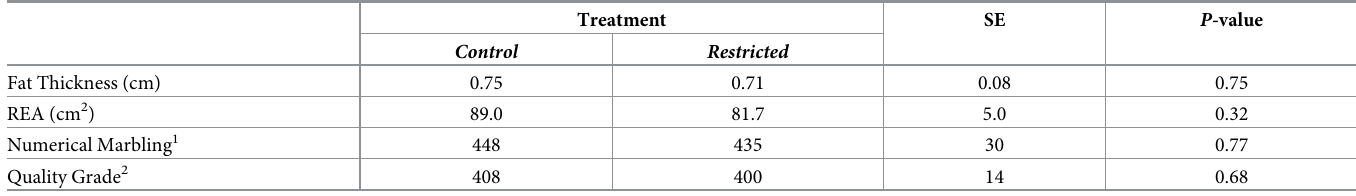
Table 7. Effects of maternal nutritional energy restriction (100% vs 70%) from GD 158 to parturition on carcass quality of Angus cross offspring fed ad libitum from PND 315 to PND 485 (n = 16).